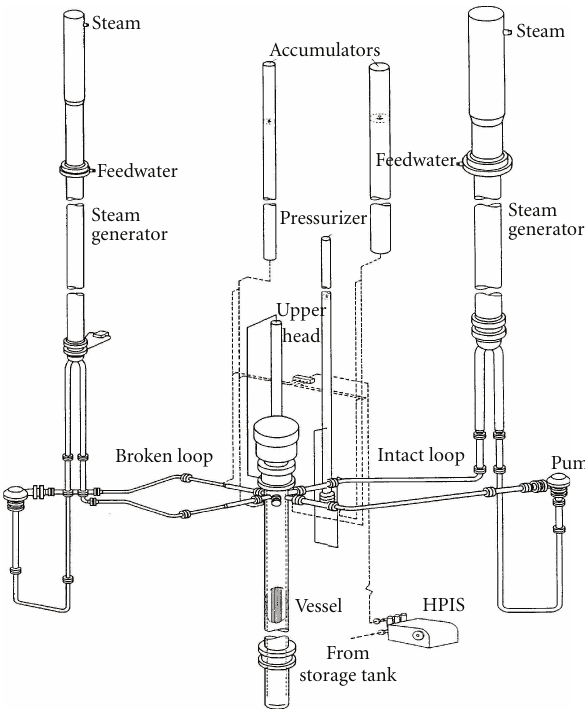
Figure 2: Schematic view of the LOBI test facility.